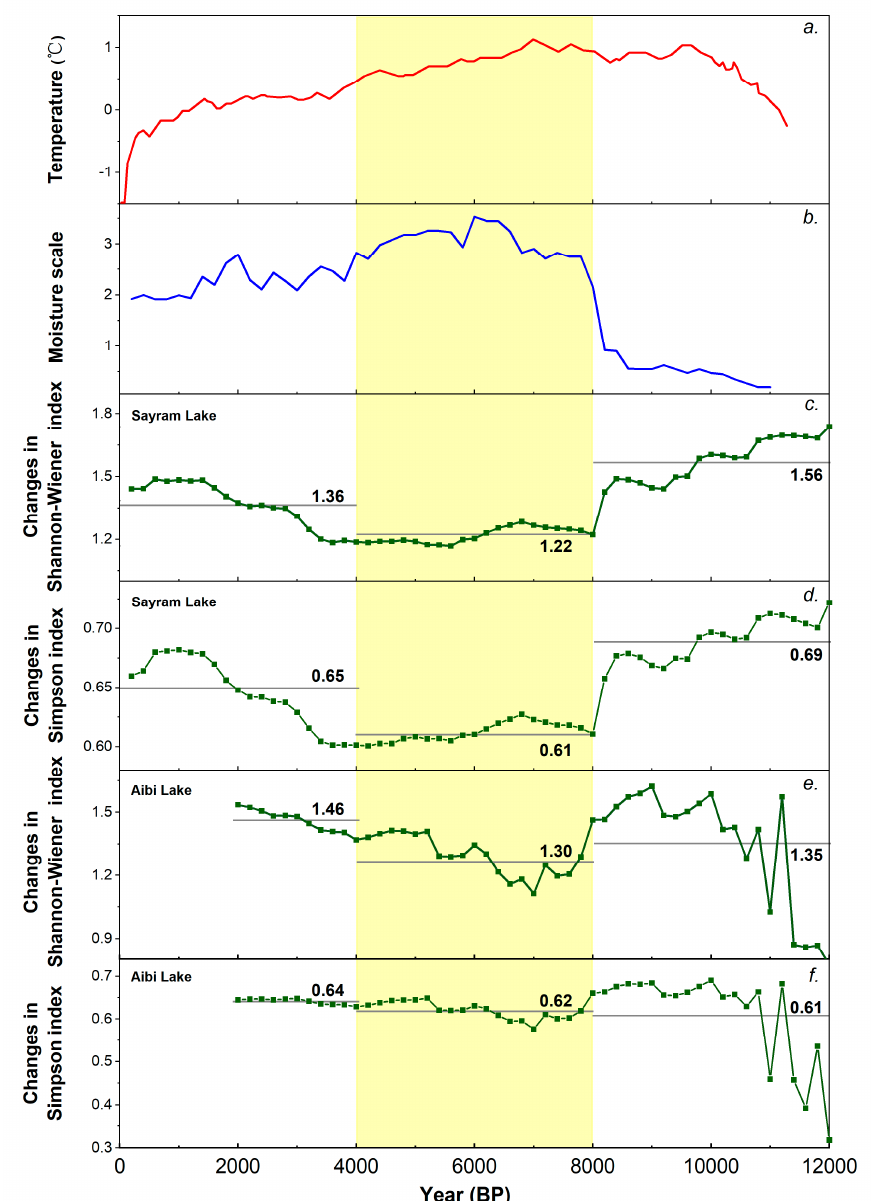
Figure 5. Changes in pollen taxa diversity in the Tien Mountains and the Holocene climate. ( a ) Holocene temperature change for 30–90° N [29,30]. ( b ) Holocene moisture changes in arid central Asia [16]. Gray lines represent mean levels of pollen taxa diversity index during different periods around Sayram Lake and Aibi Lake. ( c – f ) The yellow area represents the middle Holocene with low pollen taxa diversity.